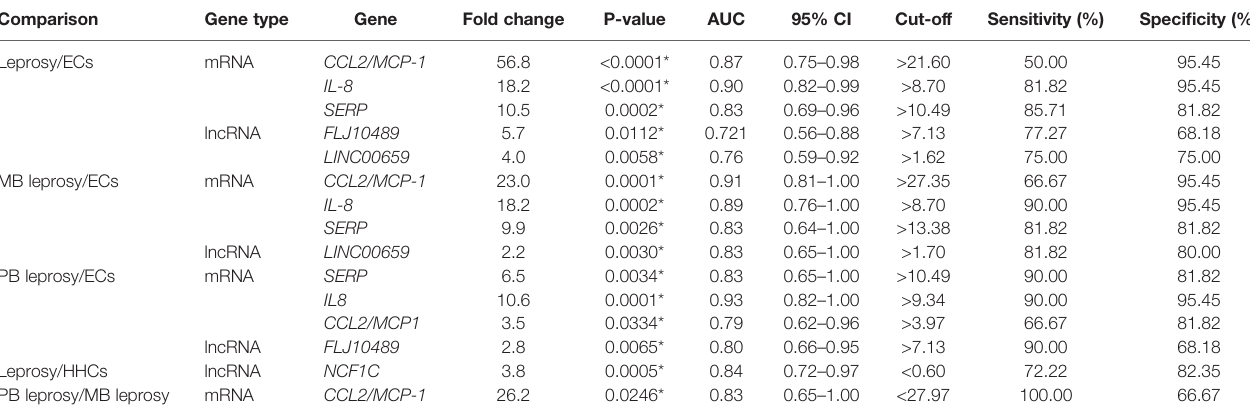
TABLE 2 | Diagnostic potential of host biomarkers detected in M. leprae -stimulated PBMCs using RT-qPCR in discriminating leprosy patients from controls. Comparison